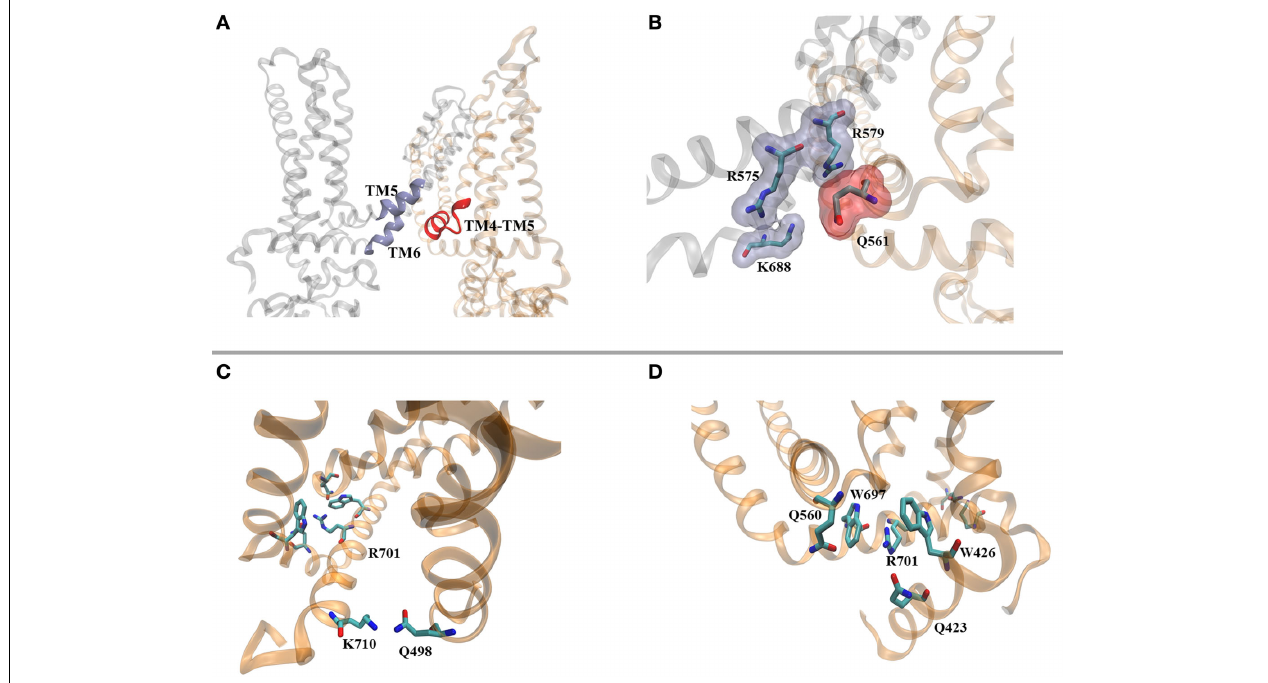
FIGURE 2 | PIP 2 mediates intra- and inter-subunit contacts. (A) Identified PIP 2 binding pocket in the structure of TRPV1. (B) Residues proposed as mediators of PIP 2 interaction to the channel. (C) K710 is located at the distal end of the TD helix and interacts with Q498 located at the bottom of TM2. (D) Predicted/potential cation- π interactions connecting the TRP box of the TD helix with the TM4-TM5